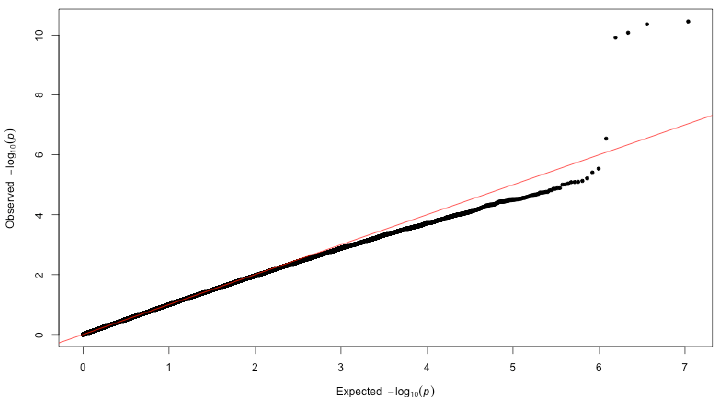
( p ) (y-axis) and expected 10